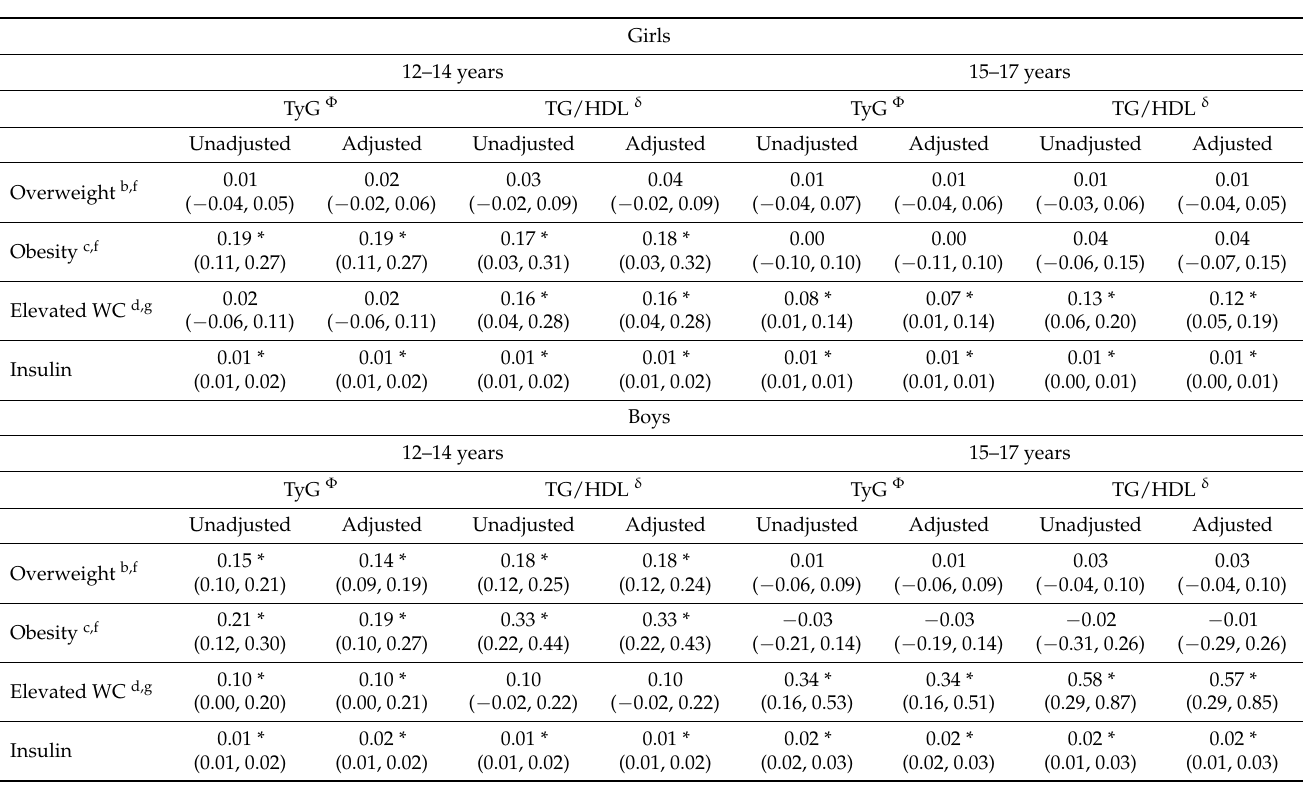
Table 2. Unadjusted and multivariable adjusted ‡ linear regression coefficients (absolute differences) and 95% confidence intervals expressing associations of waist circumference, overweight, and obesity with insulin resistance markers stratified by sex and age in 37,815 adolescents included in the Study of Cardiovascular Risk Factors (ERICA,